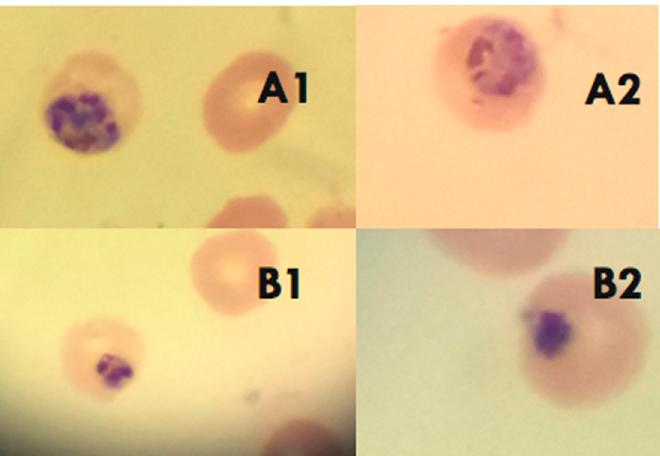
Figure 6. Morphological changes induced by pumilacidins A and C. Panel A1 and A2 : Untreated parasites. Panel B1 and B2 : P. falciparum- infected erythrocytes in the schizont stage were treated with 10 μ M pumilacidins A and C, and their morphology was analyzed 48 h after treatment through Giemsa-stained smears.